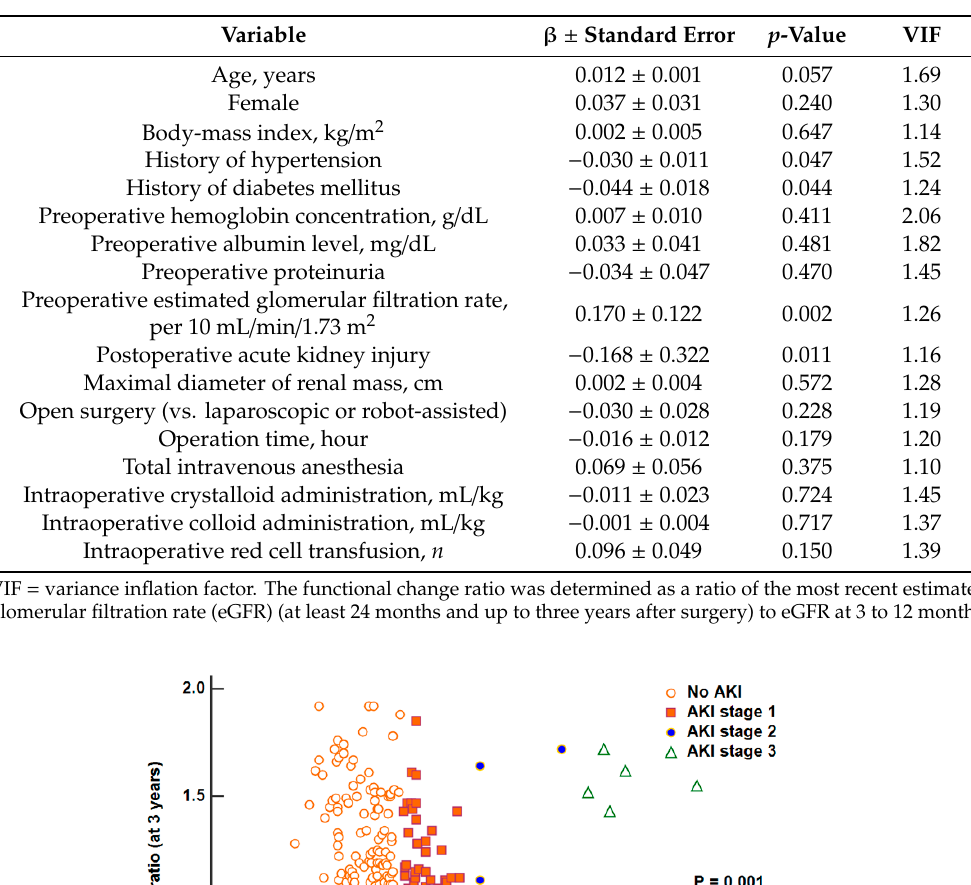
Table 3. Multivariable linear regression analysis of functional change ratio after radical nephrectomy.